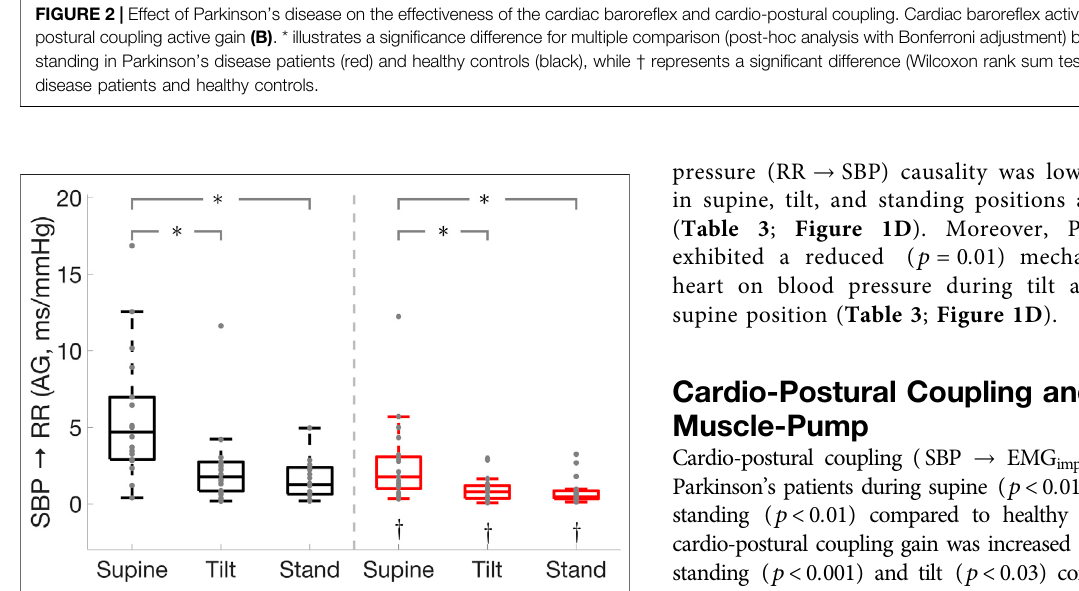
FIGURE 3 | Effect of Parkinson ’ s disease on the cardiac barore fl ex ( SBP → RR ) activegaininthehigh-frequencyband.*illustratesasigni fi cance difference for multiple comparison (post-hoc analysis with Bonferroni adjustment) between supine, tilt, and standing in Parkinson ’ s disease patients (red) and healthy controls (black), while † represents a signi fi cant difference(Wilcoxonranksumtest)betweenParkinson ’ sdiseasepatientsand healthy